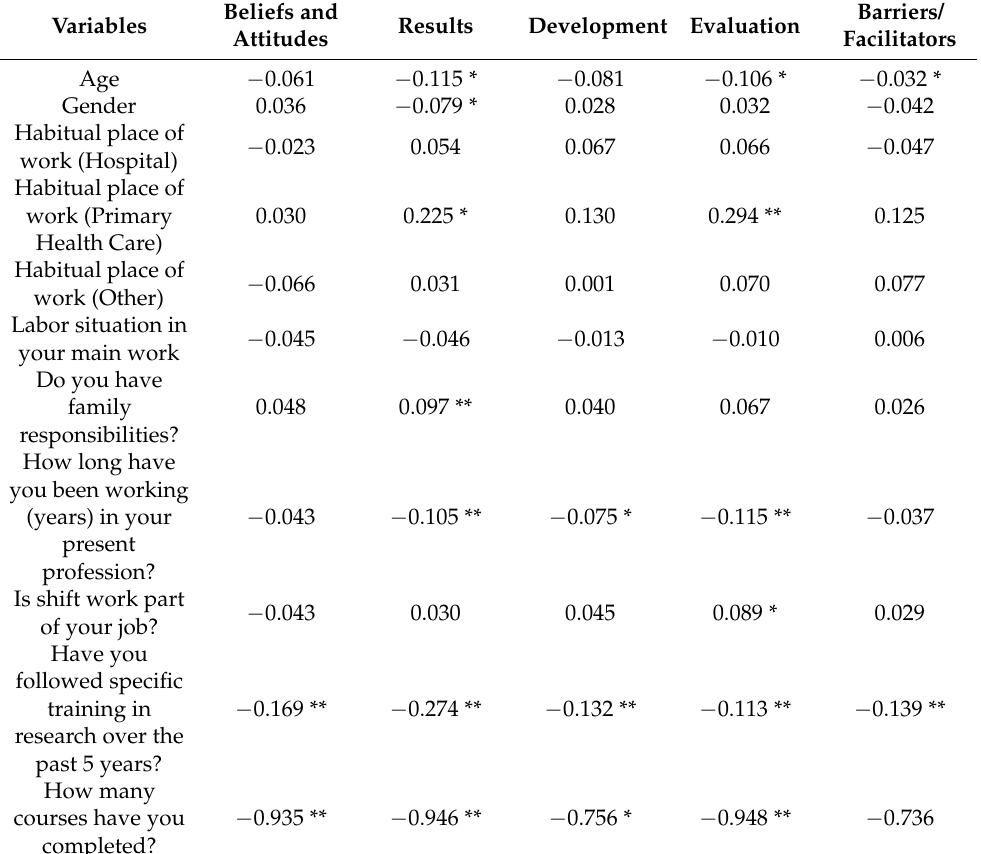
Table 2. Correlational study between sociodemographic variables and subscales of the HS-EBP 30 questionnaire.